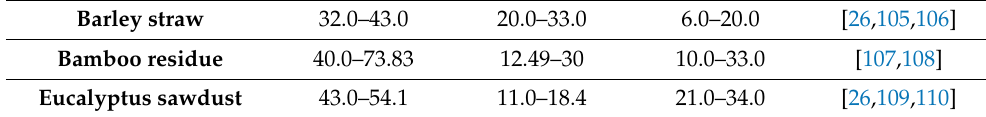
Table 7. Chemical composition of other selected lignocellulosic biomasses. Barley